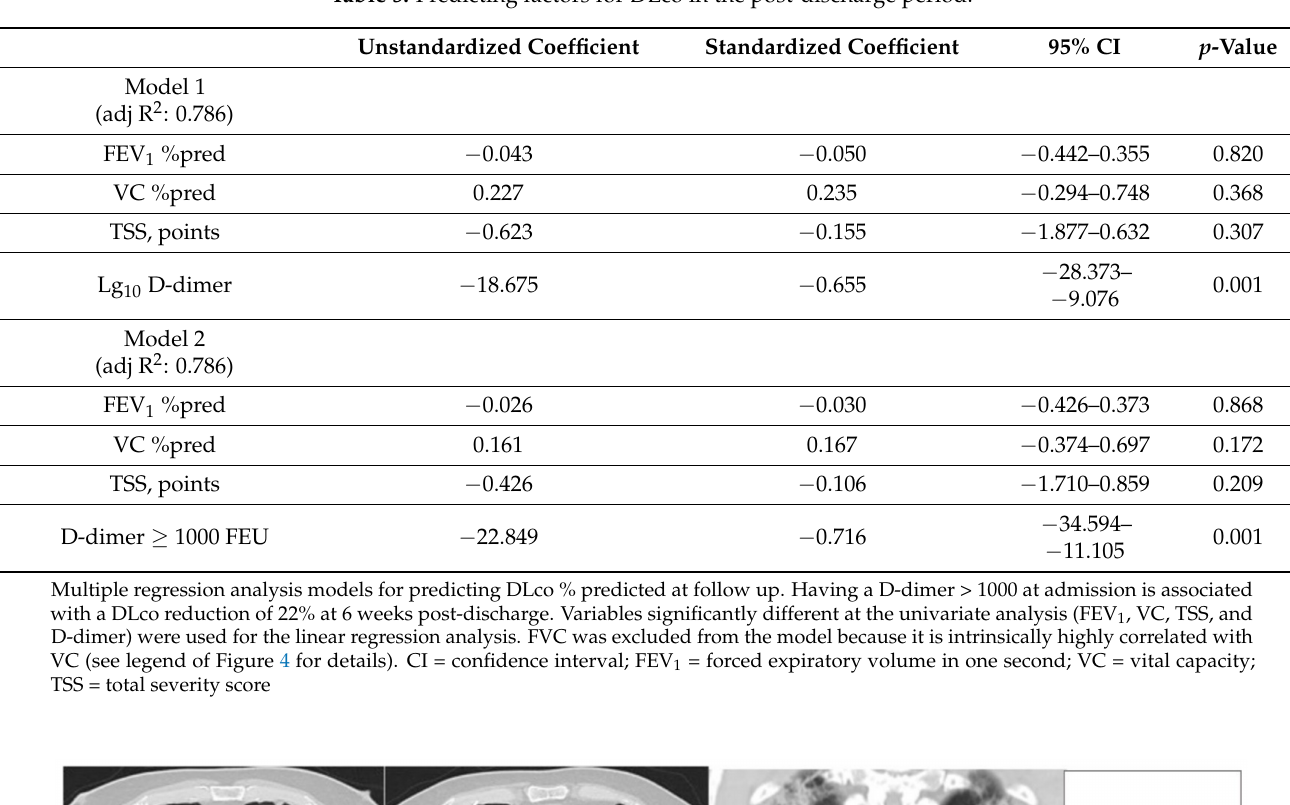
Table 5. Predicting factors for DLco in the post-discharge period.